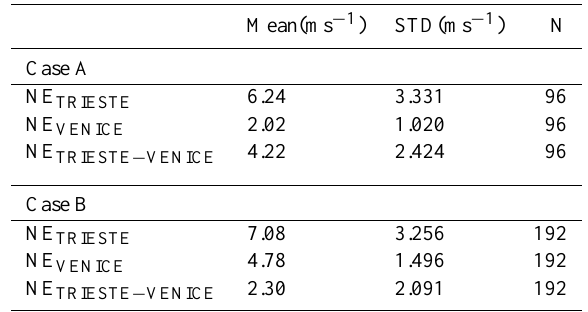
Table 1. Northeasterly wind means and standard deviations at Tri- este and Venice and corresponding differences for two bora cases: 8–11 February (A) and 12–19 February 1984 (B). N is the number of hourly values included in the